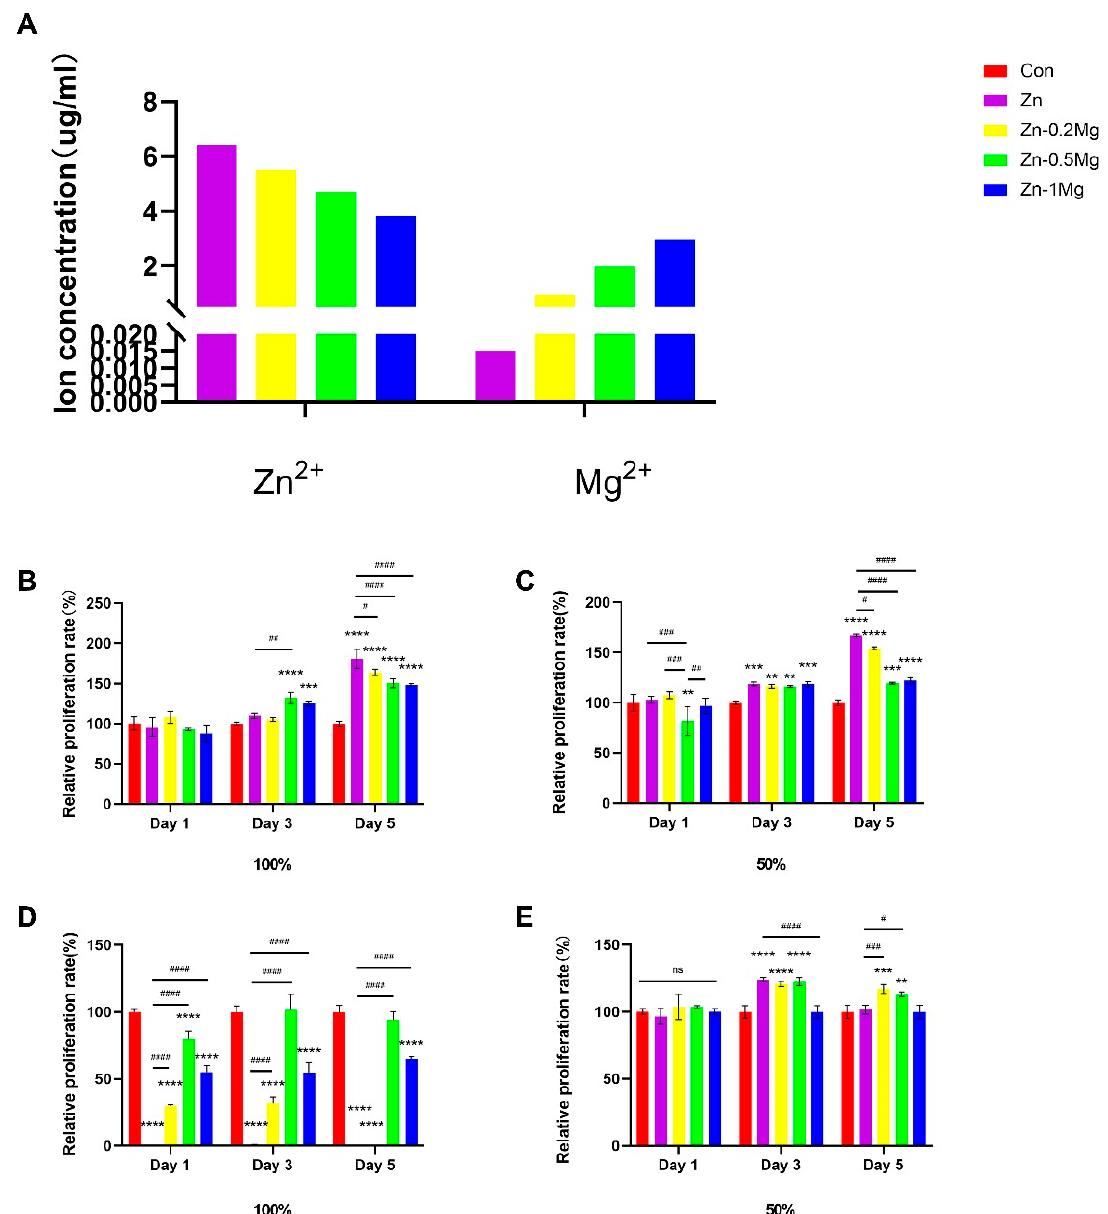
Figure 3. ( A ) Results of Zn 2+ and Mg 2+ release, measured with ICP-OES in α -MEM, and relative proliferation rate of ( B , C ) VECs incubated in original and two-fold dilution extract; ( D , E ) MC3T3-E1 cells incubated in original and two-fold dilution extract. Compared with the control group, **** p < 0.0001, *** p < 0.001 and ** p < 0.01; compared with the Zn group, #### p < 0.0001, ### p < 0.001, ## p < 0.01, and # p < 0.05; (ns) indicates no statistical significance.